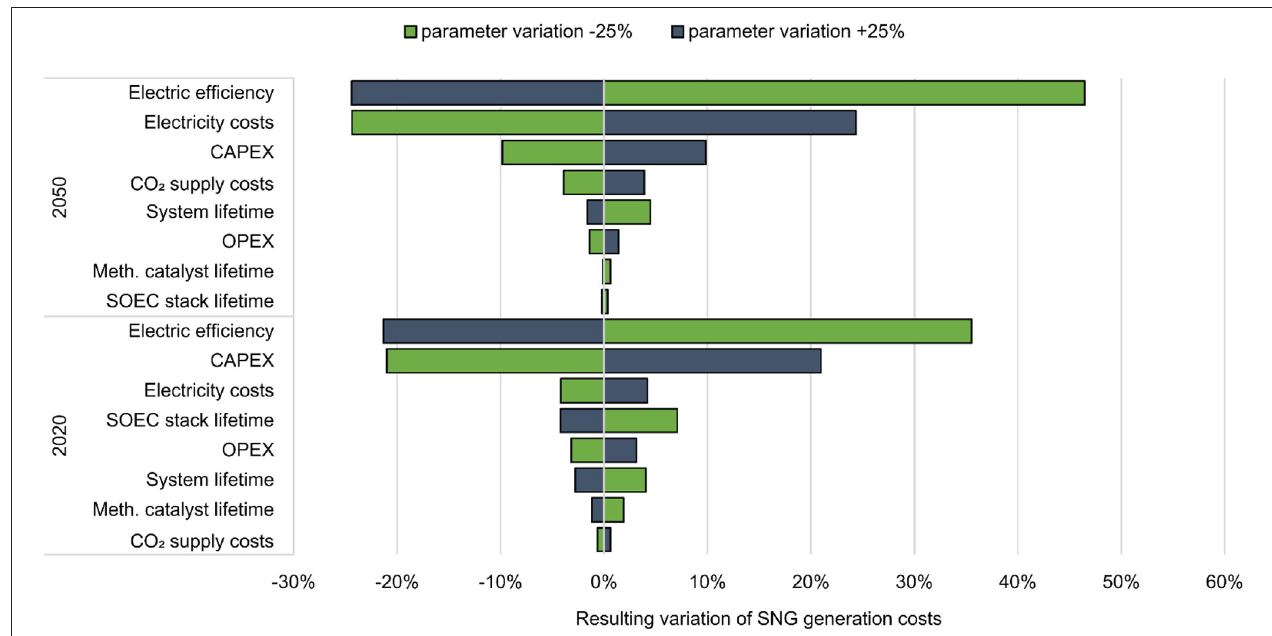
FIGURE 9 | Impact of calculation parameter variation on the resulting SNG generation costs.